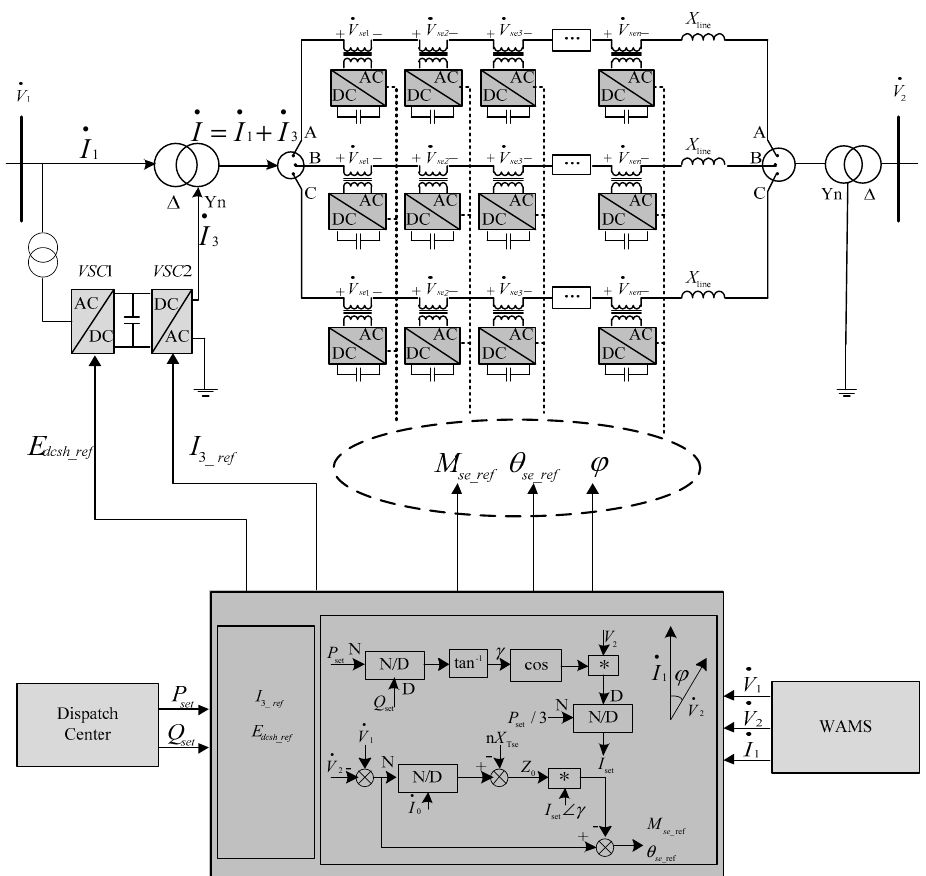
Figure 3. The structure of the coordination control system of a DPFC.